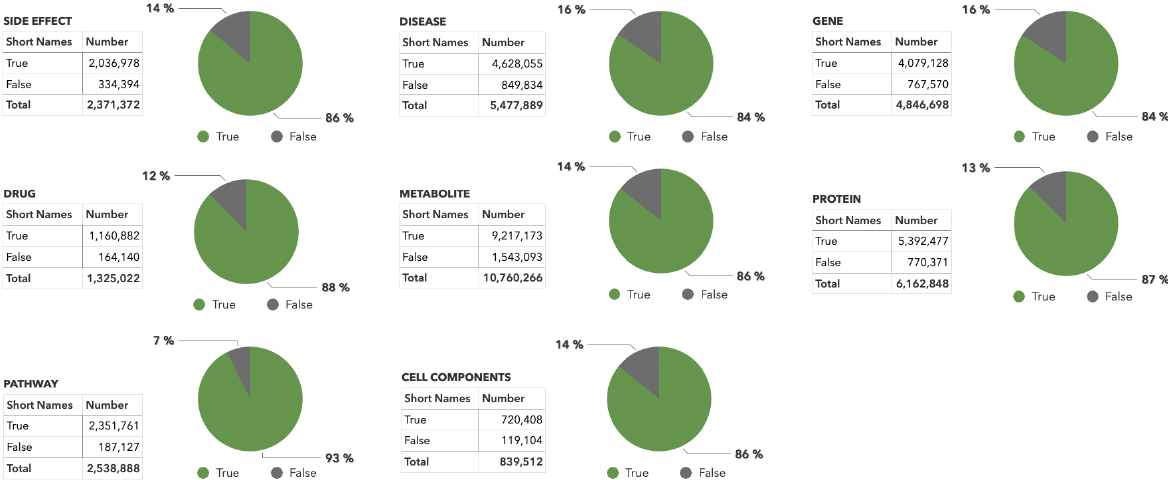
Figure 4. Proportions of correctly and incorrectly recognized short object words in PubMed texts after dictionary-based mapping and filtering with the developed fine-tuned neural networks. Short object names’ absolute numbers and proportions are based on their correctly or incorrectly recognized classification. Table 2. AUC values for each model, calculated using the existing gold standards for objects of any length, and for short objects